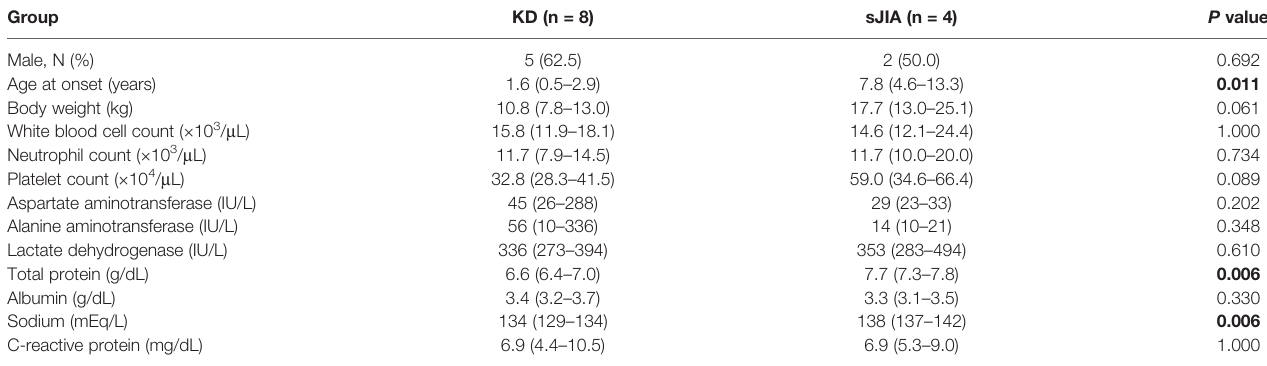
Data are expressed as median values and interquartile range (25th, 75th percentile), or number (proportion, %). Bold values indicate statistically signi fi cance in patient characteristics between KD group and sJIA